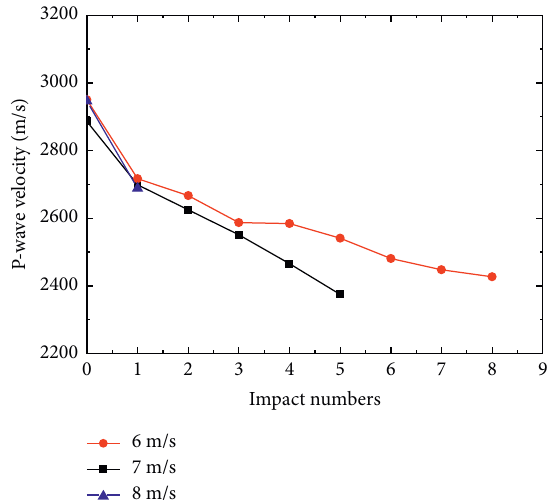
Figure 8: Relationships between P-wave velocity and impact numbers with diferent impact velocities.